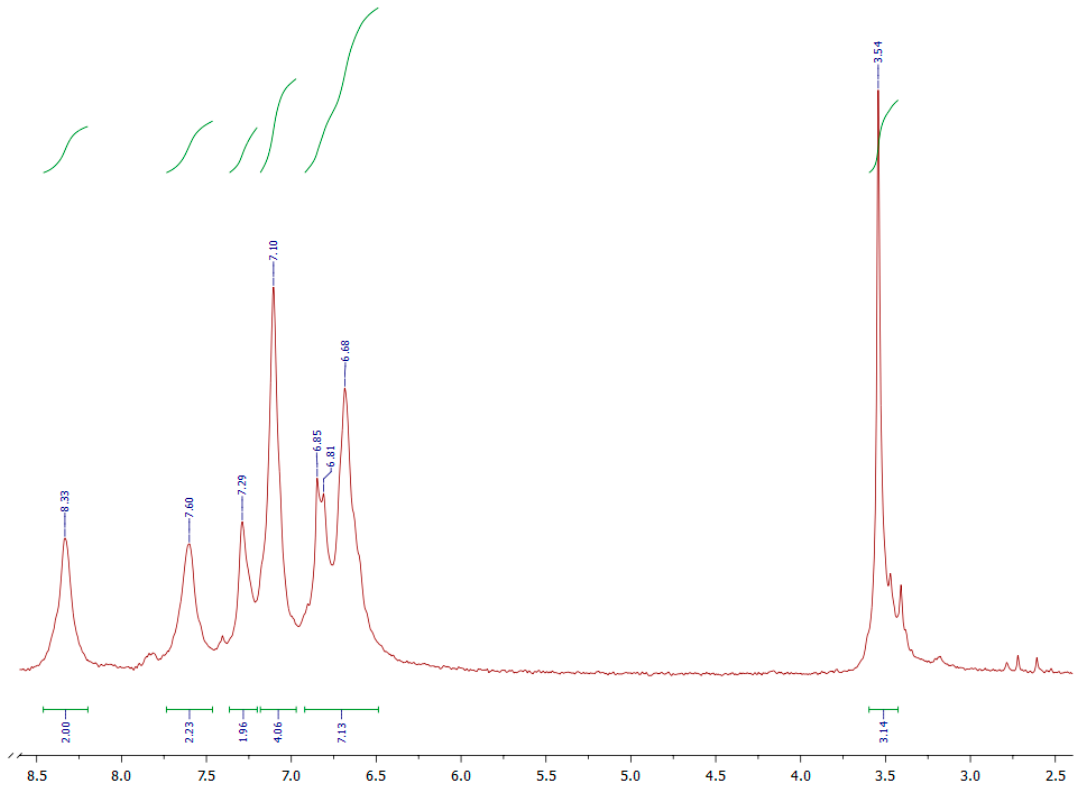
Figure 7. 1 H NMR spectrum of polyazomethine polymer P-V in CDCl 3 .